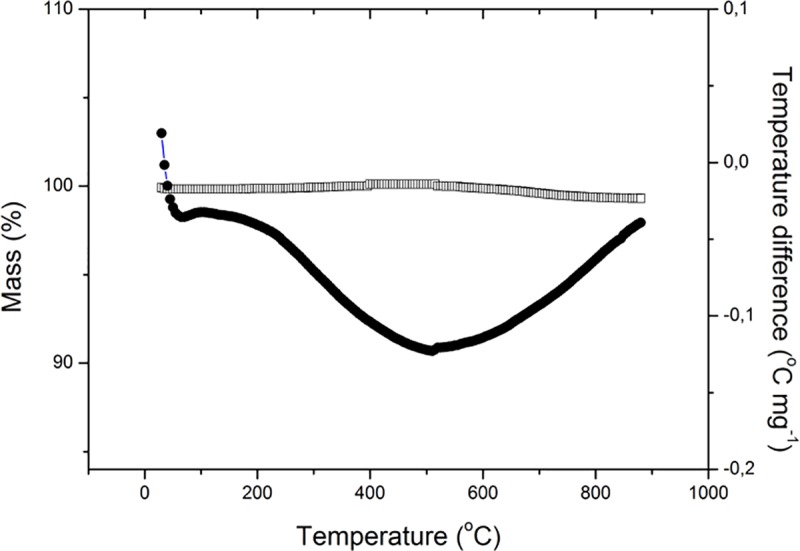
TG/DTA analysis of MnCo2O4 nanoparticles.